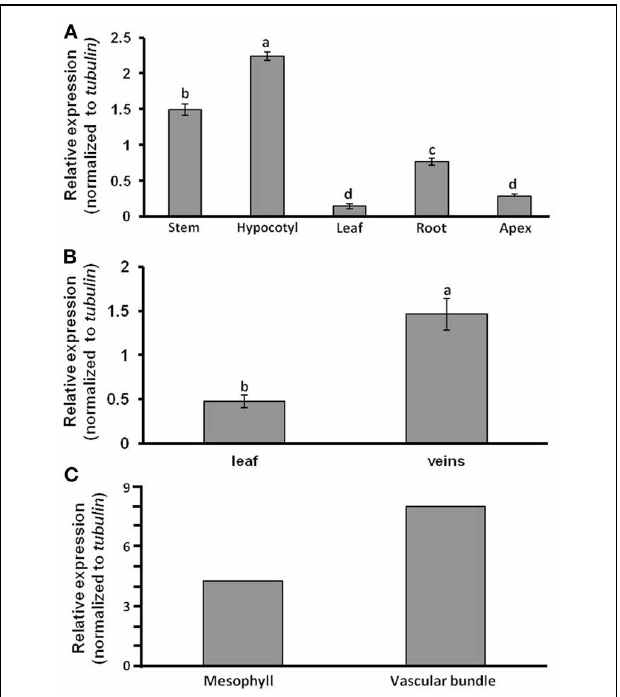
FIGURE 1 | Relative expression levels of CmF-308 , as determined by real-time RT-PCR. Relative expression was compared in various melon plant organs (A) , in veins and leaf lamina (B) and in mesophyll and vascular bundle cells isolated by laser-capture microdissection system (C) . Leaf discs and single cells were collected from the youngest mature source leaf (no. 4). Data represent means of three to six replications ( ± SE). Different letters indicate significant differences between plant organs or cell types at p < 0 . 05 by Tukey’s